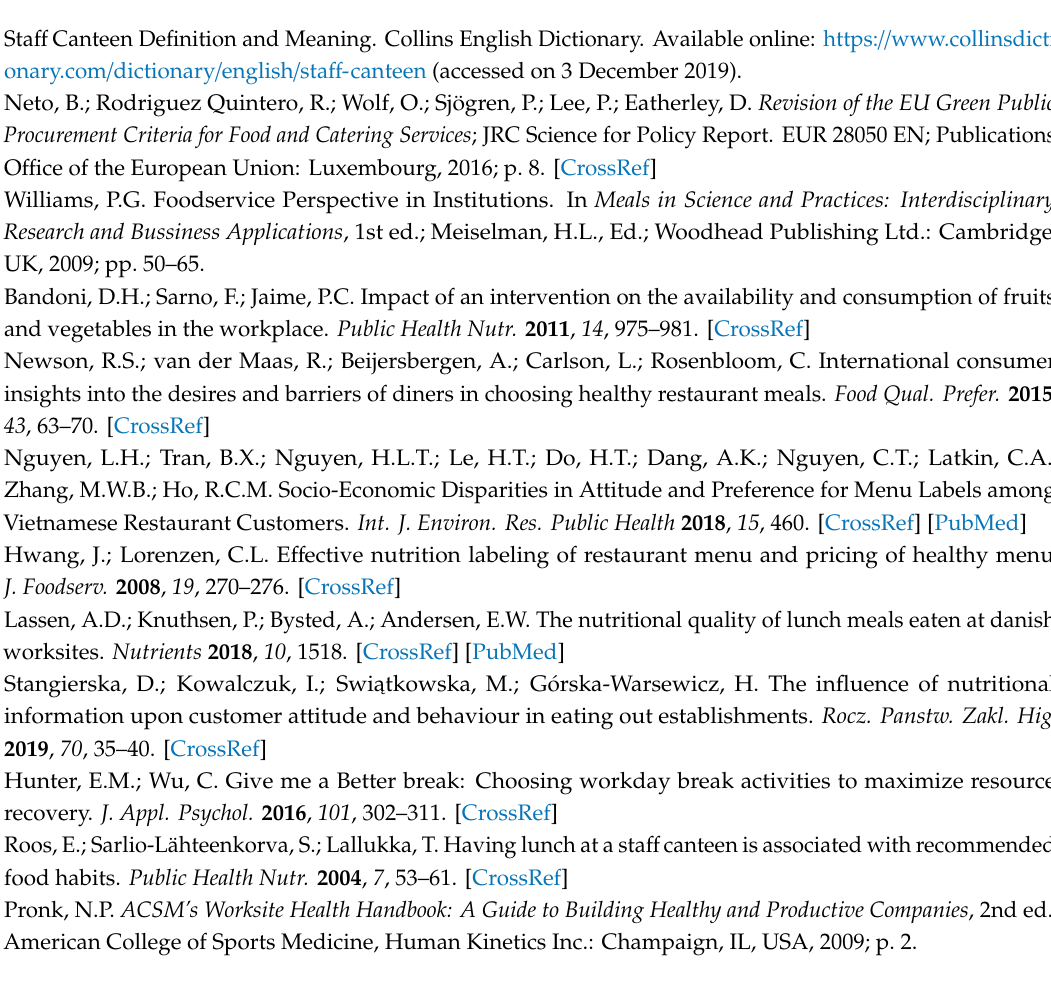
Table S1: Questionnaire